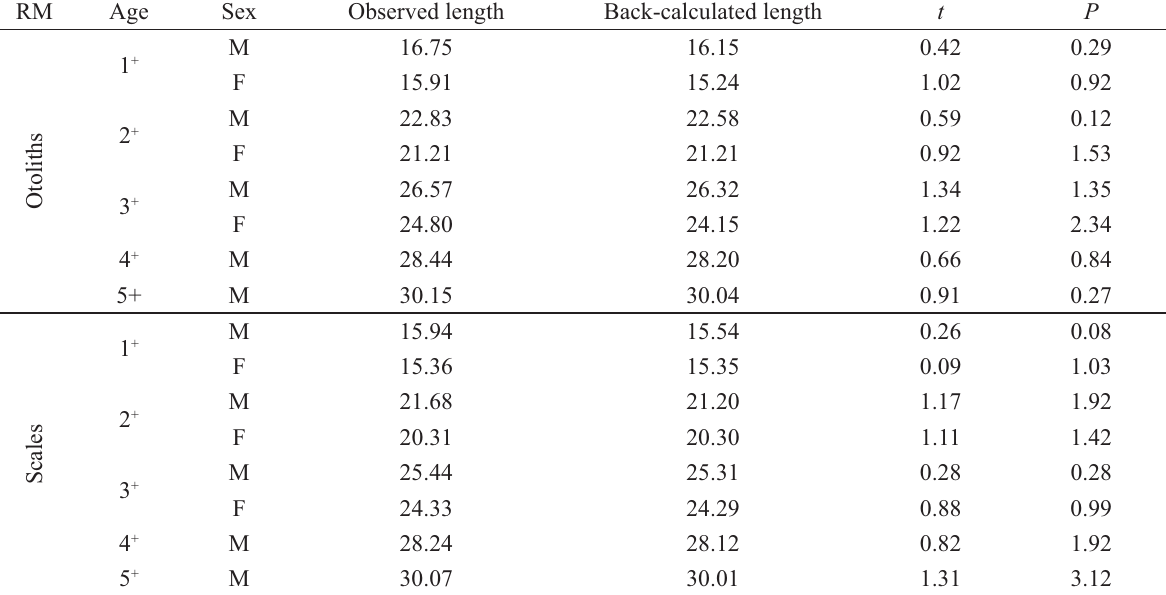
Comparison of the observed lengths at different ages with back-calculation lengths for peacock